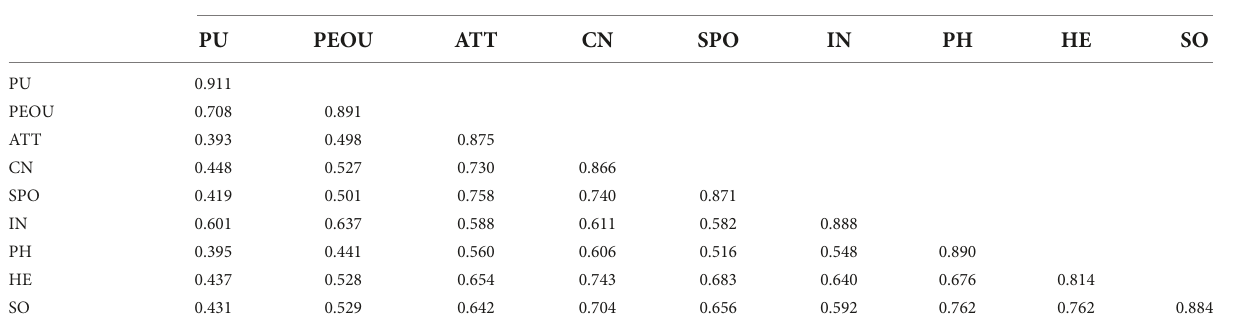
TABLE 4 Discriminant validity test of all dimensions of scale.